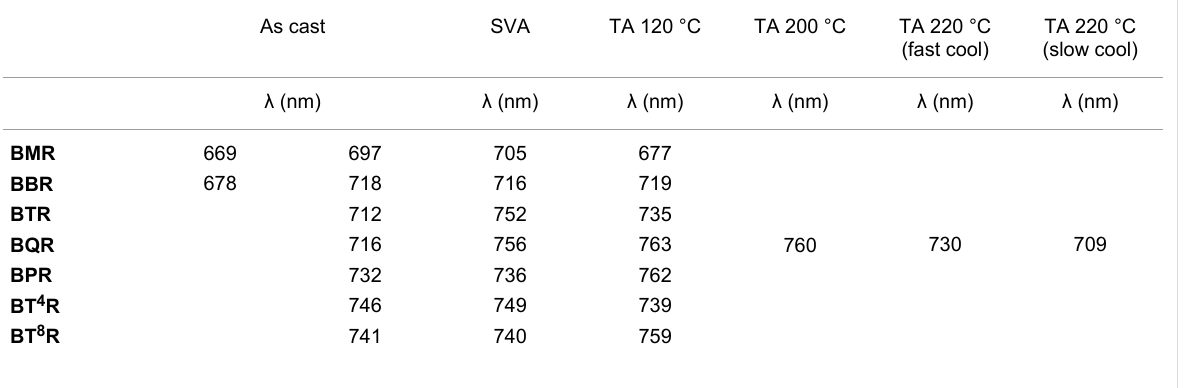
Table 2: Extracted fluorescence emission peak positions for the BX x R materials ( λ excit 580 nm).